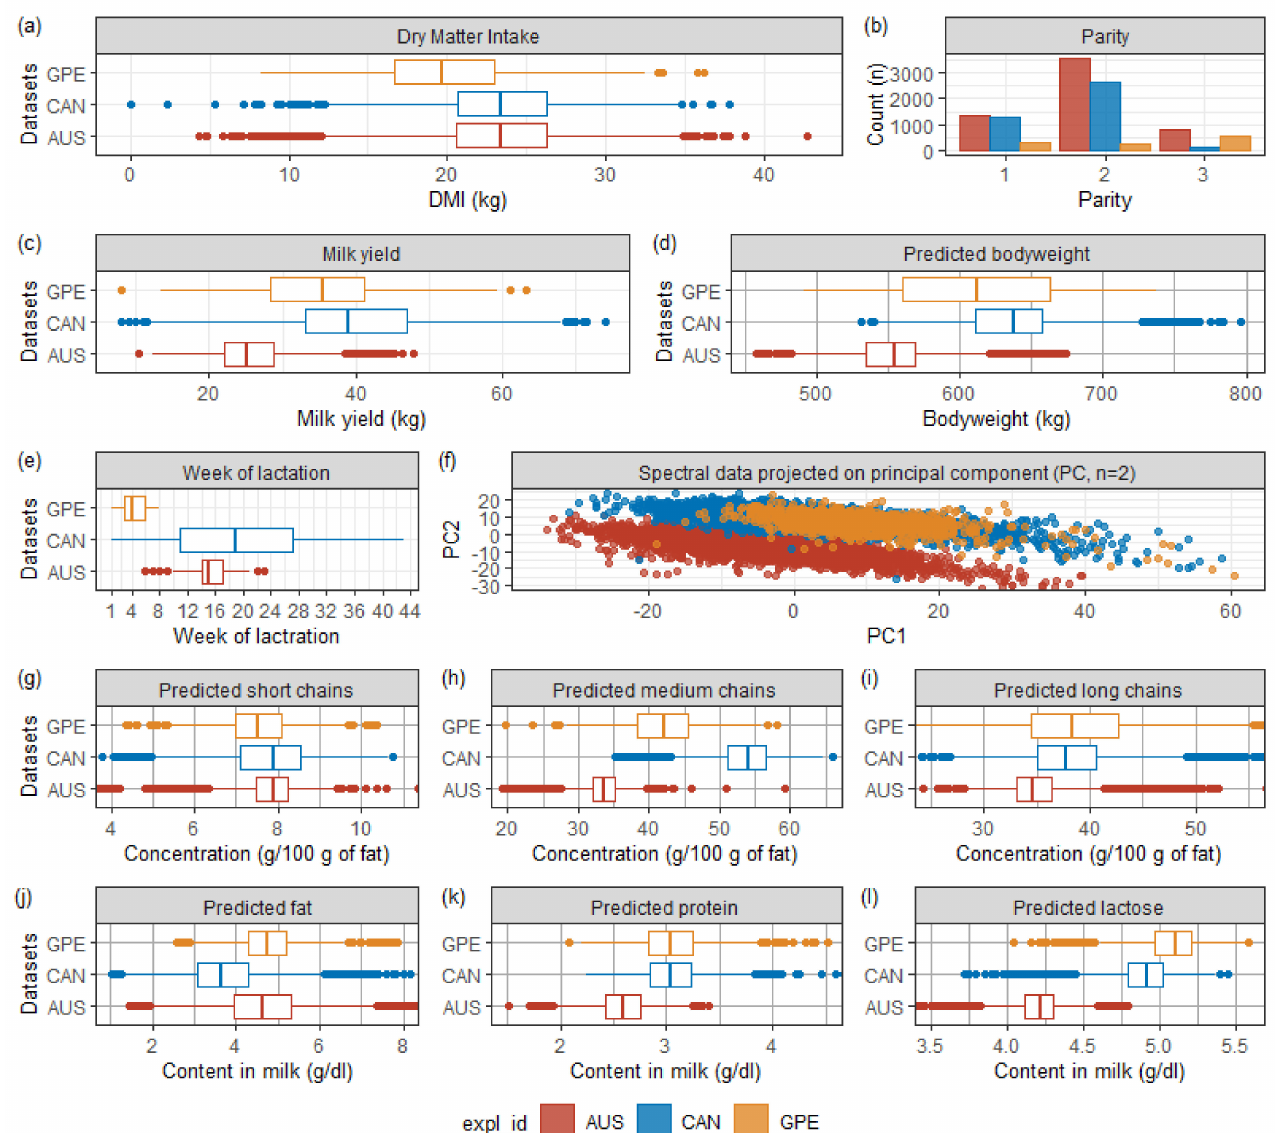
Figure 1. Descriptive statistics of the training datasets (red = AUS, blue = CAN, orange = GPE). ( a ) Measured dry matter intake; ( b ) Parity; ( c ) Milk yield; ( d ) Bodyweight predicted from regression involving milk mid-infrared spectra, parity, days in milk, and milk yield; ( e ) Week of lactation; ( f ) Projection of the milk mid-infrared spectra to their first two principal components computed from a principal component analysis involving 277 spectral points; ( g ) Prediction of short chains fatty acids from milk mid-infrared spectra; ( h ) Prediction of medium chains fatty acids from milk mid-infrared spectra; ( i ) Prediction of long chains fatty acids from milk mid-infrared spectra; ( j ) Prediction of fat content in milk from milk mid-infrared spectra; ( k ) Prediction of protein content in milk from milk mid-infrared spectra; ( l ) Prediction of lactose content in milk from milk mid-infrared